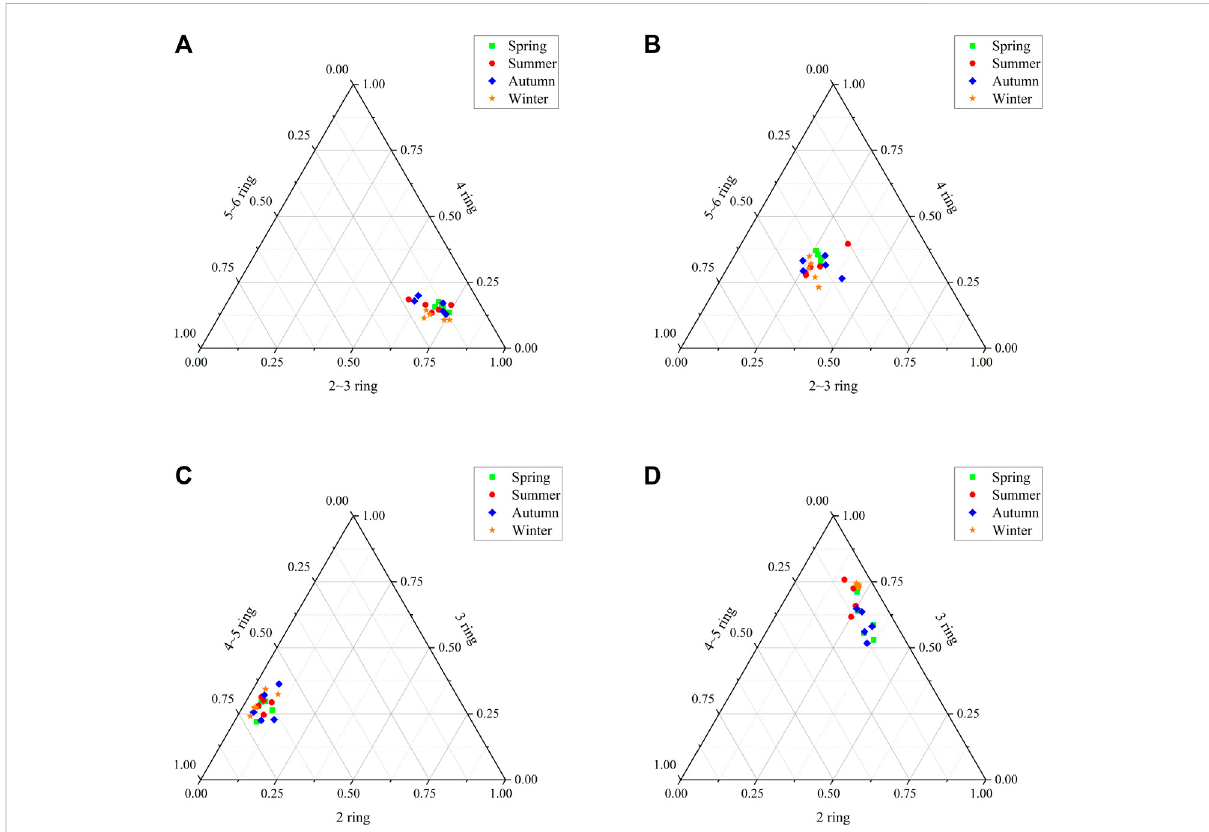
FIGURE 3 Triangle diagram of different kinds of PAHs for the seasonal distribution [Seasonal distribution of low and high ring of total PAHs (A) ; Seasonal distributionof2 – 3,4and5 – 6ringofp-PAHs (B) ;Seasonaldistributionof2,3and4 – 5ringofp-PAHs (C) ;Seasonaldistributionof2,3and4 – 5ringof a-PAHs (D) ].